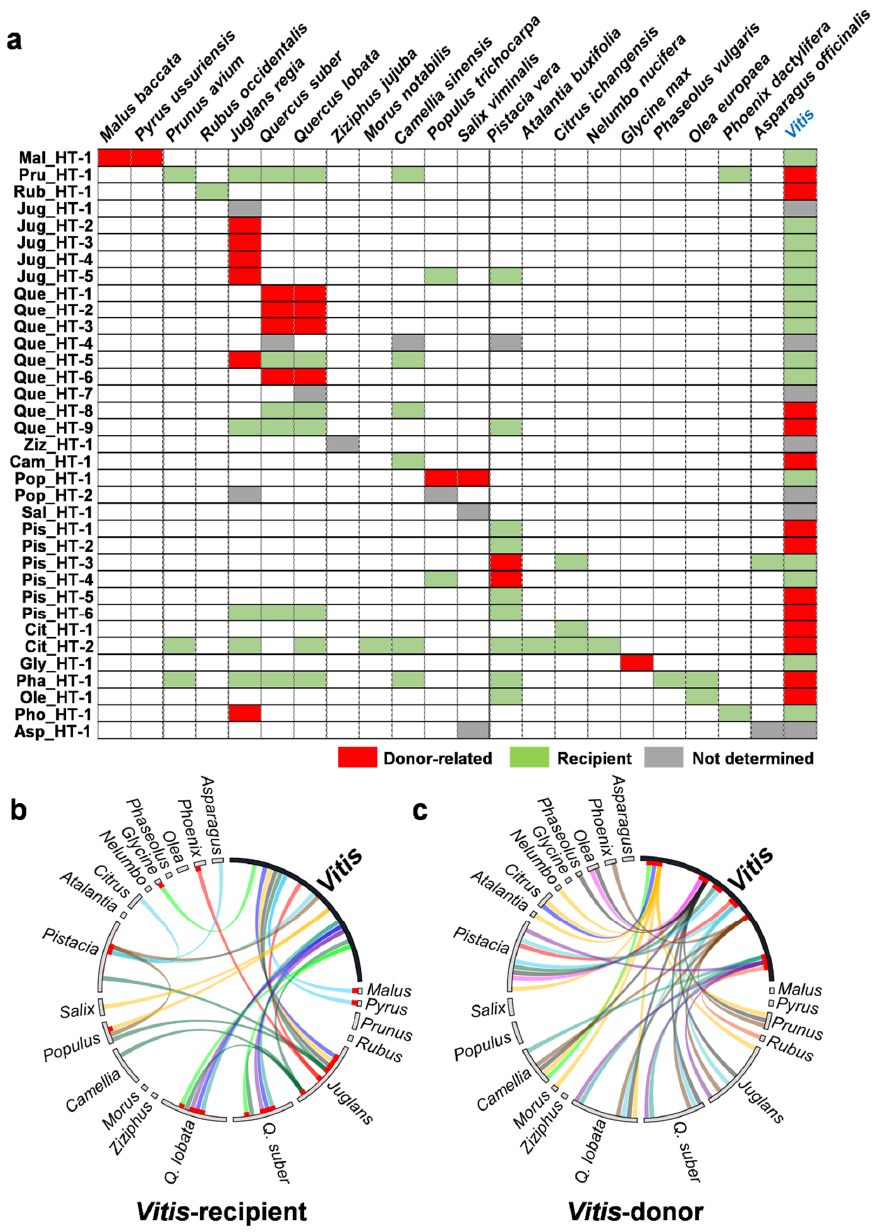
Figure 4. Donor and recipient of the 35 HT events. ( a ) The donor, recipient, and undetermined species are presented with red, green, and gray boxes, respectively. The columns and rows indicate the species and each HT event, respectively. The name of the species and Vitis genus is shown at the top of the panel. The name of the HT event is shown on the left side of the panel. ( b , c ) Circos plots representing HT events when Vitis was the recipient ( b ) or donor ( c ), respectively. The bars that comprise the circles represent the species or genus involved in the HT events, and the length of the bar represents the number of HT events in each species or genus. For each HT event, the donor is marked with a red box on the inner side of the circle bars. The lines in the circle link the donor and recipient species.